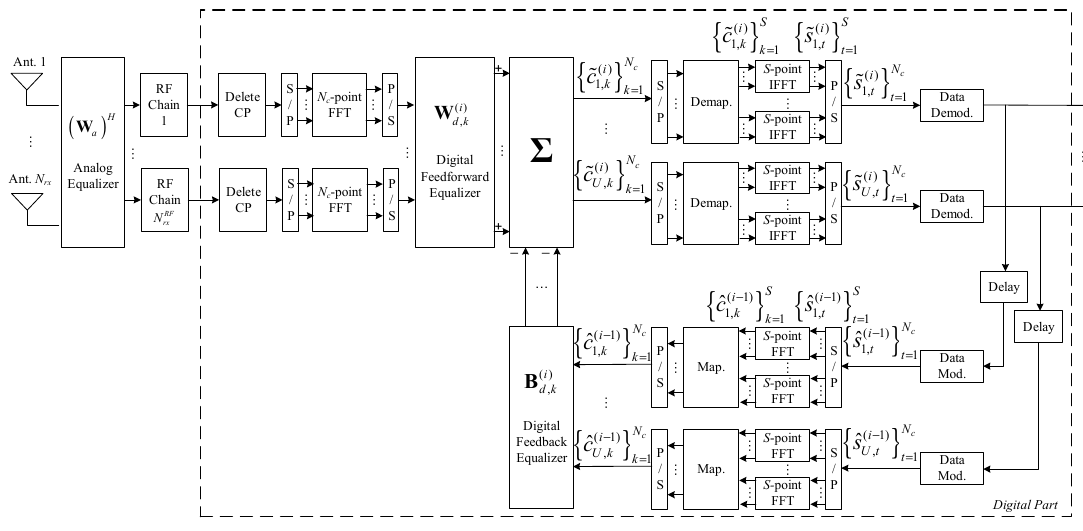
Figure 2. Proposed receiver structure.